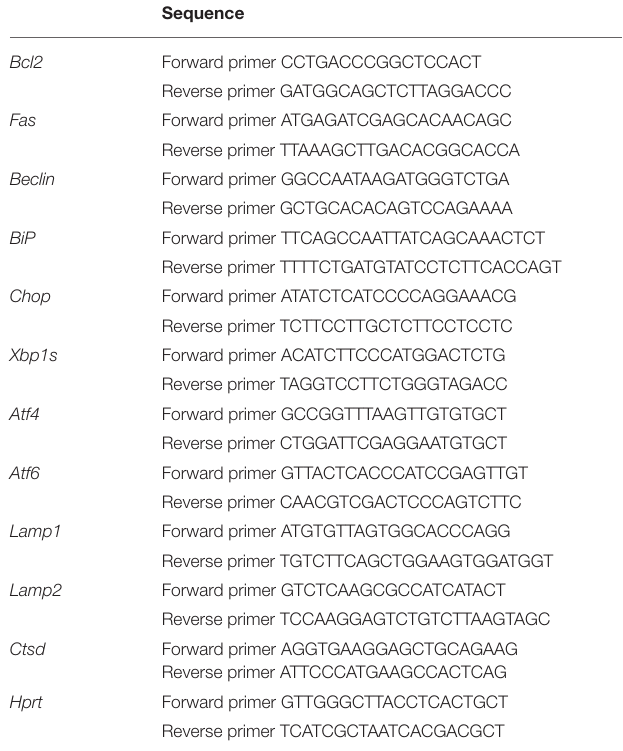
TABLE 1 | Primers used in